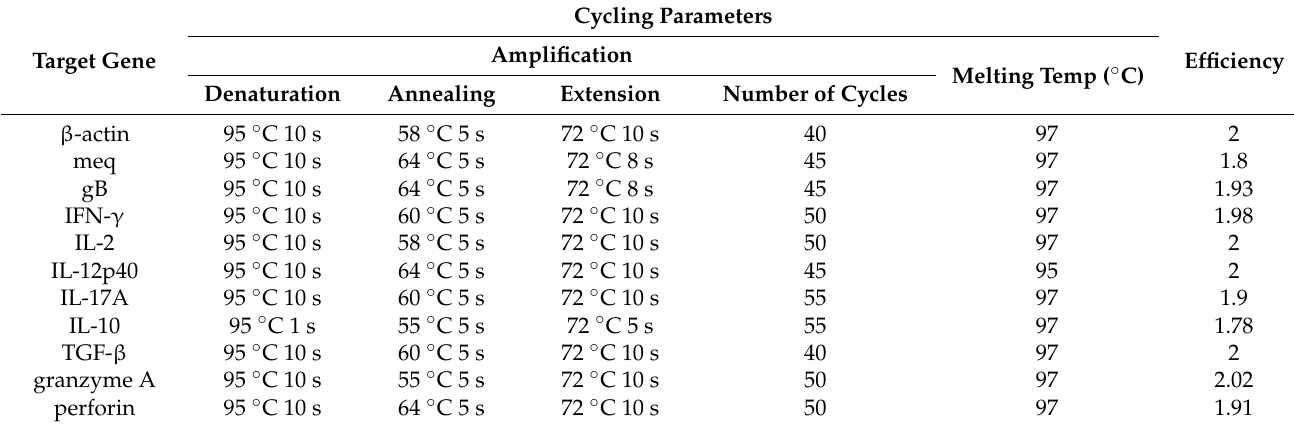
Table 3. Cycling parameters for real-time